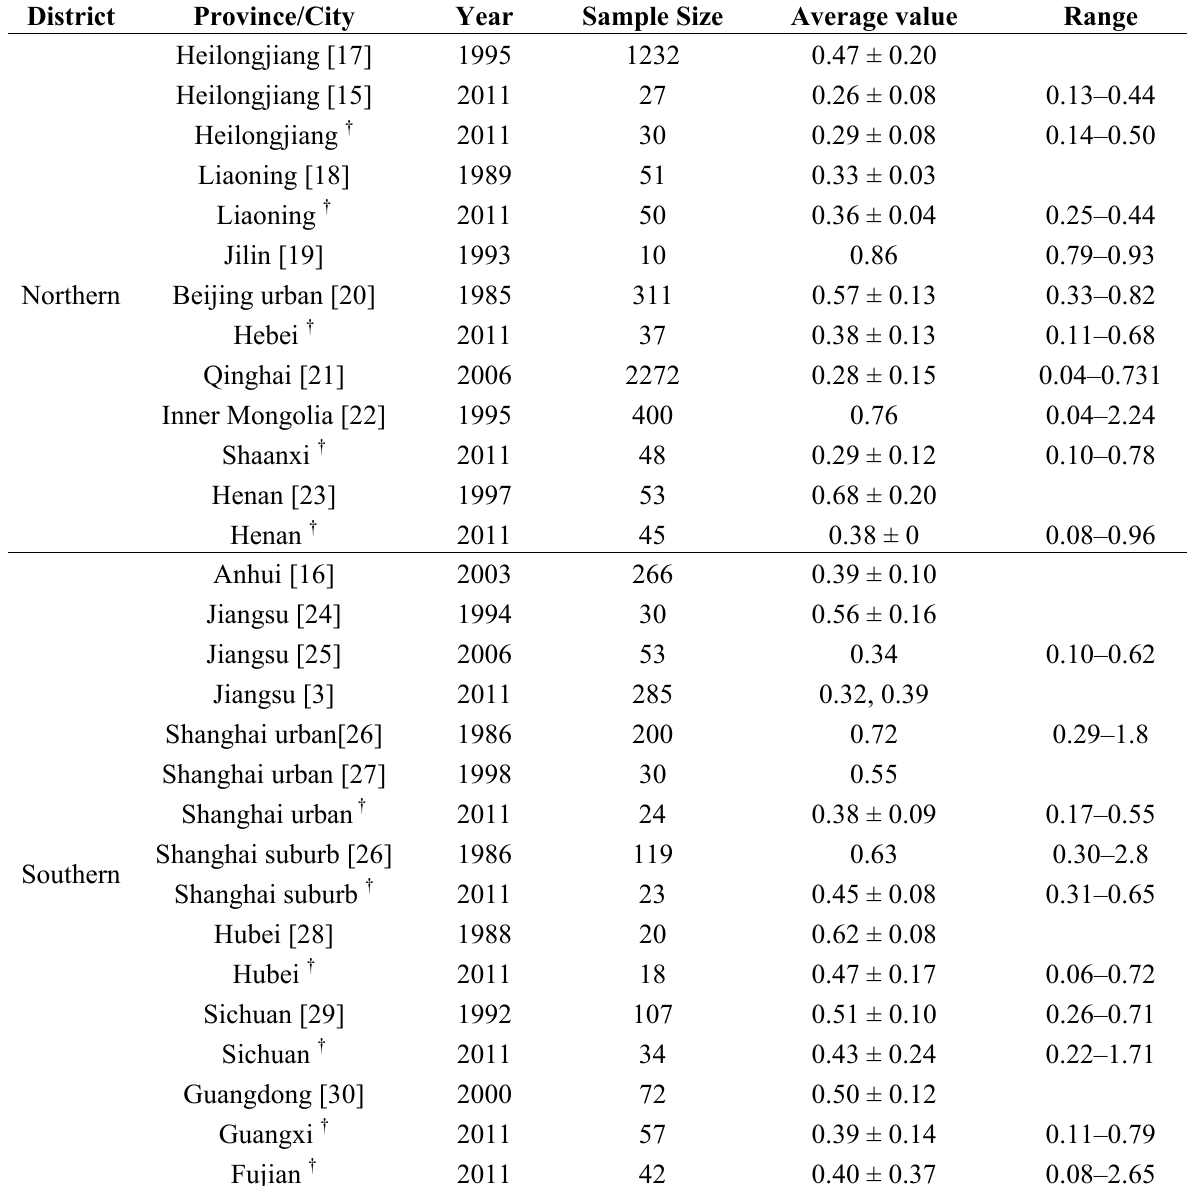
Table 2. Human hair Se content from 1985 to 2011 (mg/kg) in residents from different Chinese